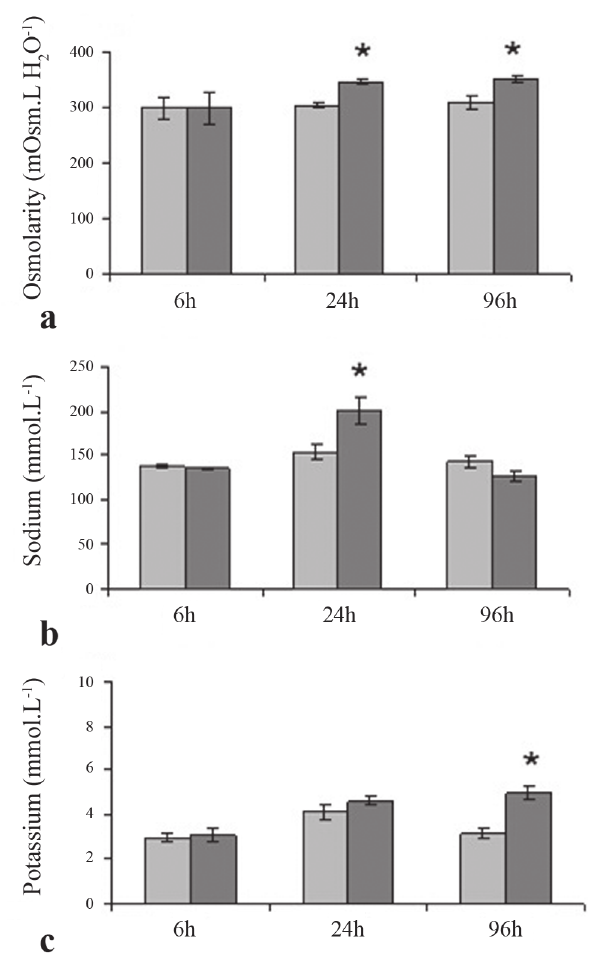
Fig. 3. Plasma osmolarity ( a ) and concentrations of Na + ( b ), K + ( c ) and Cl - ( d ) of Prochilodus lineatus exposed to WSFG (EXP) or only to water (CTR) for 6, 24 and 96h. Data are means ± SEM (n = 10-13), asterisks indicate different from respective control (P < 0.05).